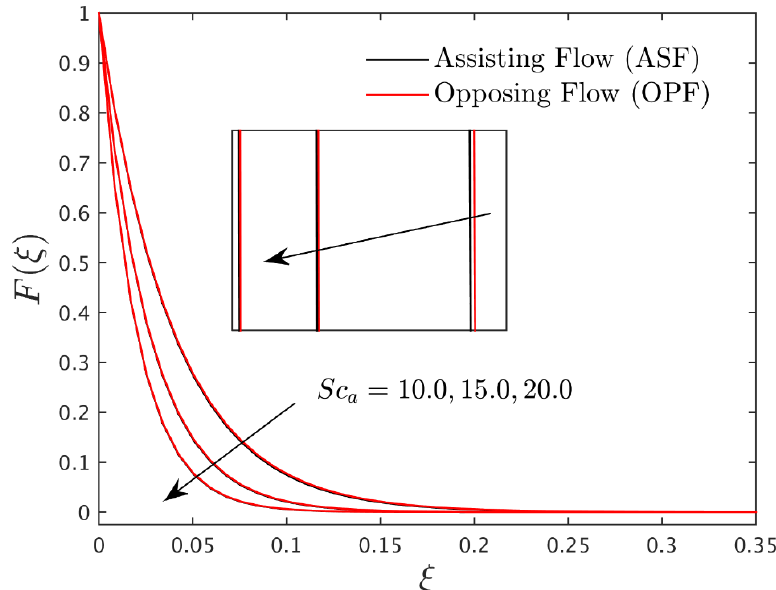
Figure 10. Concentration profile for the case of ASF and OPF due to variations in the values of Sc .